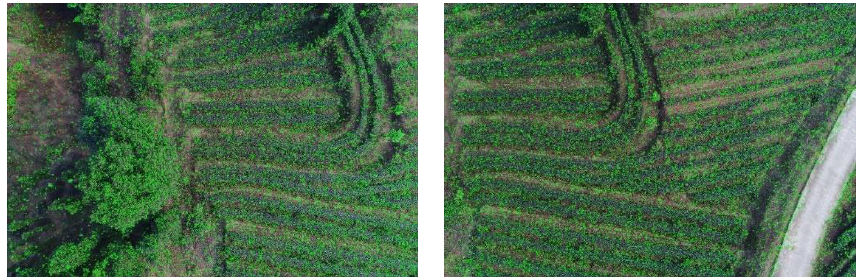
Figure 6. SIFT feature points in the tea garden images.